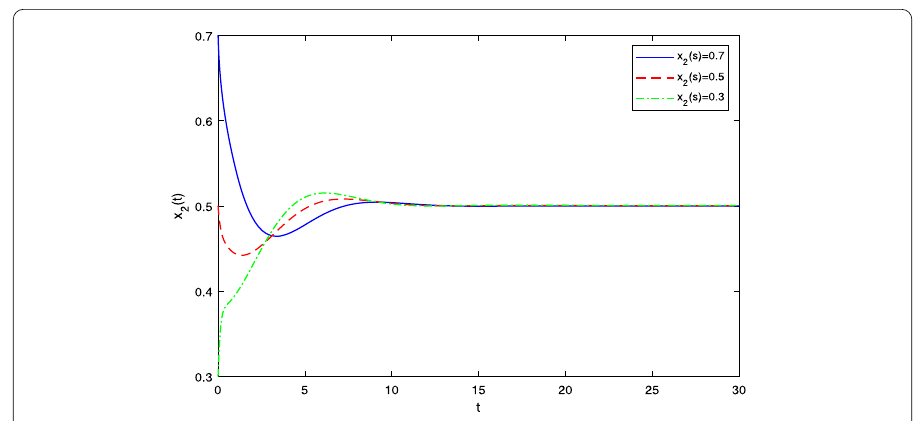
Figure 2 Time responses of state variable x 2 ( t ) with α = 0.95